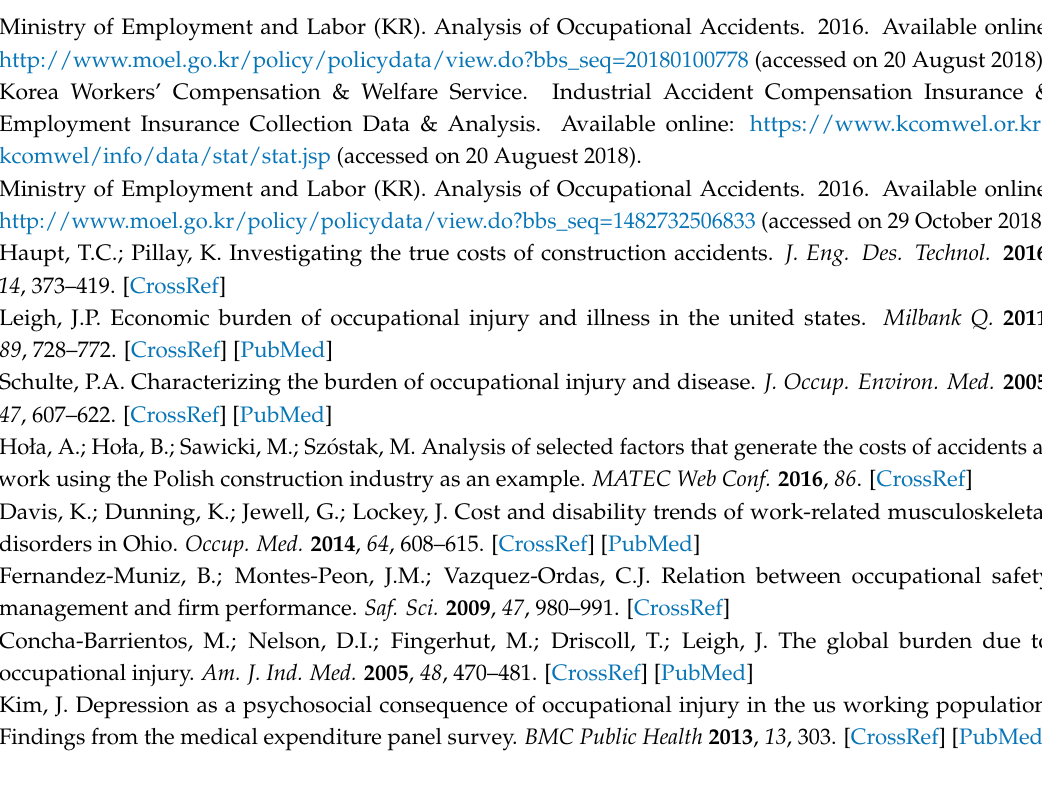
s1, Table S1: Relationship between disability rating and total earned annual income changes before and after industrial accident, Table S2: Relationship between disability rating and total non-work annual income changes before and after industrial